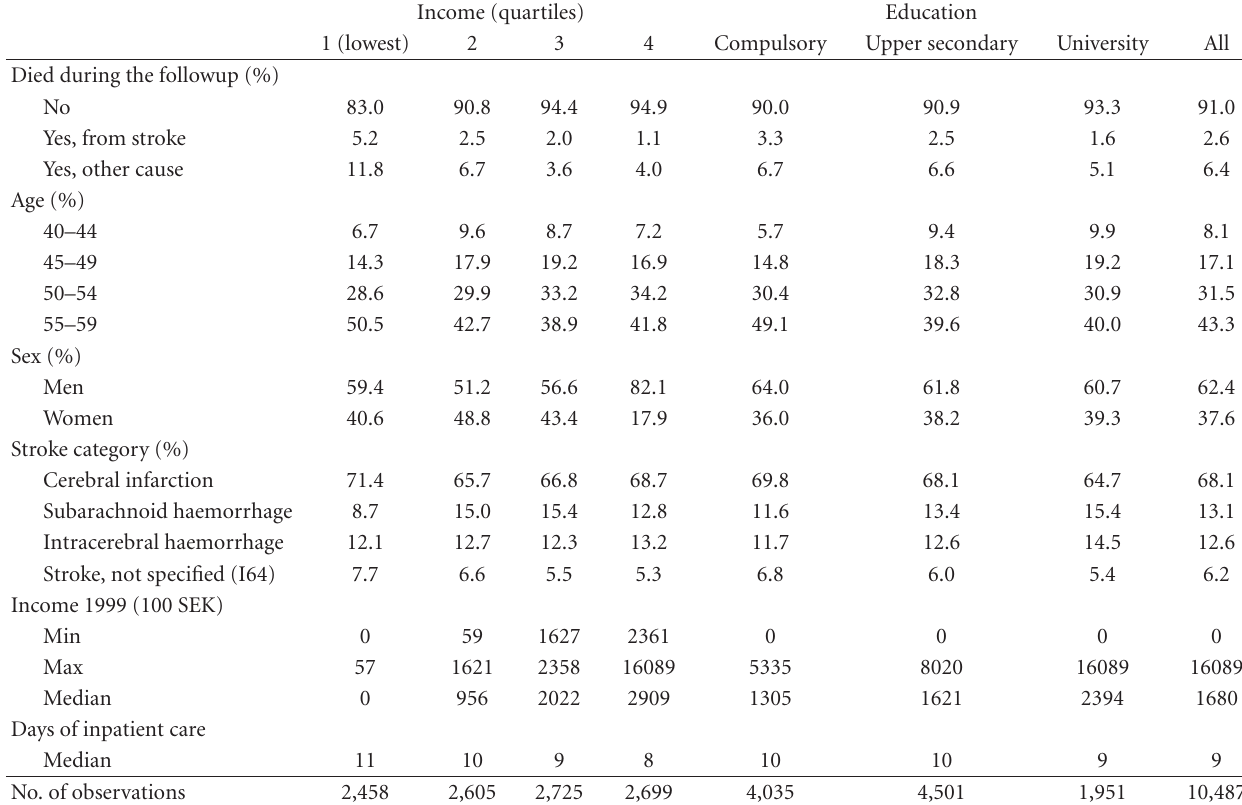
Table 1: Descriptive statistics ( n =